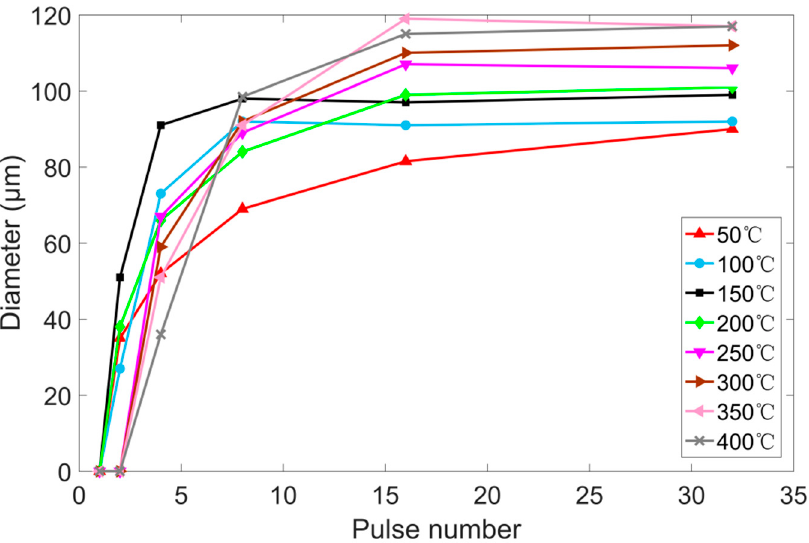
Figure 11. Diameter of different pulse number.